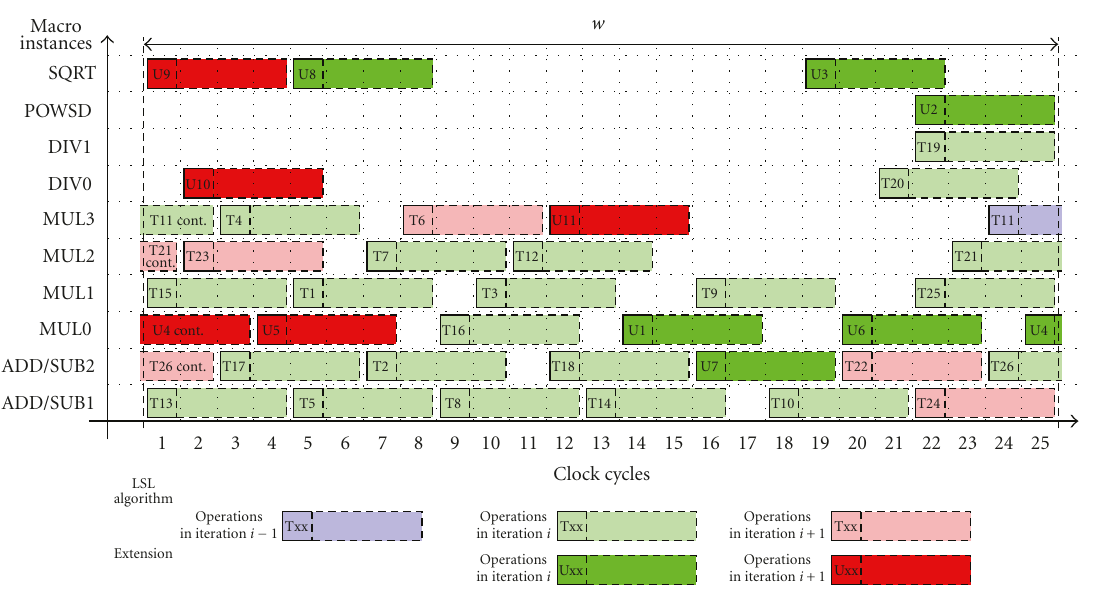
Figure 3: Schedule of operations of four RLS lattice algorithms with probability estimation. The operations Txx and Ux are defined in Algorithm 1.